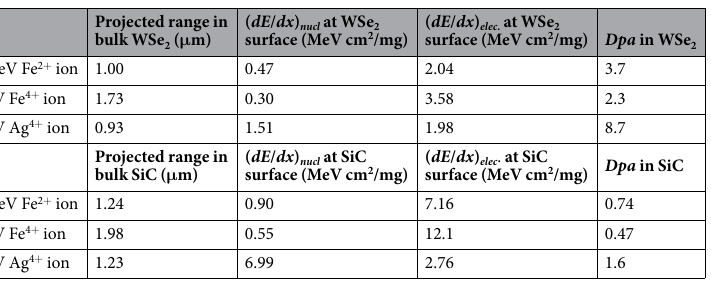
Table 1. Summary of the results from SRIM/TRIM simulation. The dpa is calculated with a fluence of 10 16 ions/ cm 2 at the top 10 nm of the material, corresponding to the detection depth of XPS measurement. The monolayer collisions calculation type was used in the SRIM/TRIM simulation. The depth profiles of ionization and dpa in the SiC substrate induced by heavy ions are shown in Supplementary Fig.